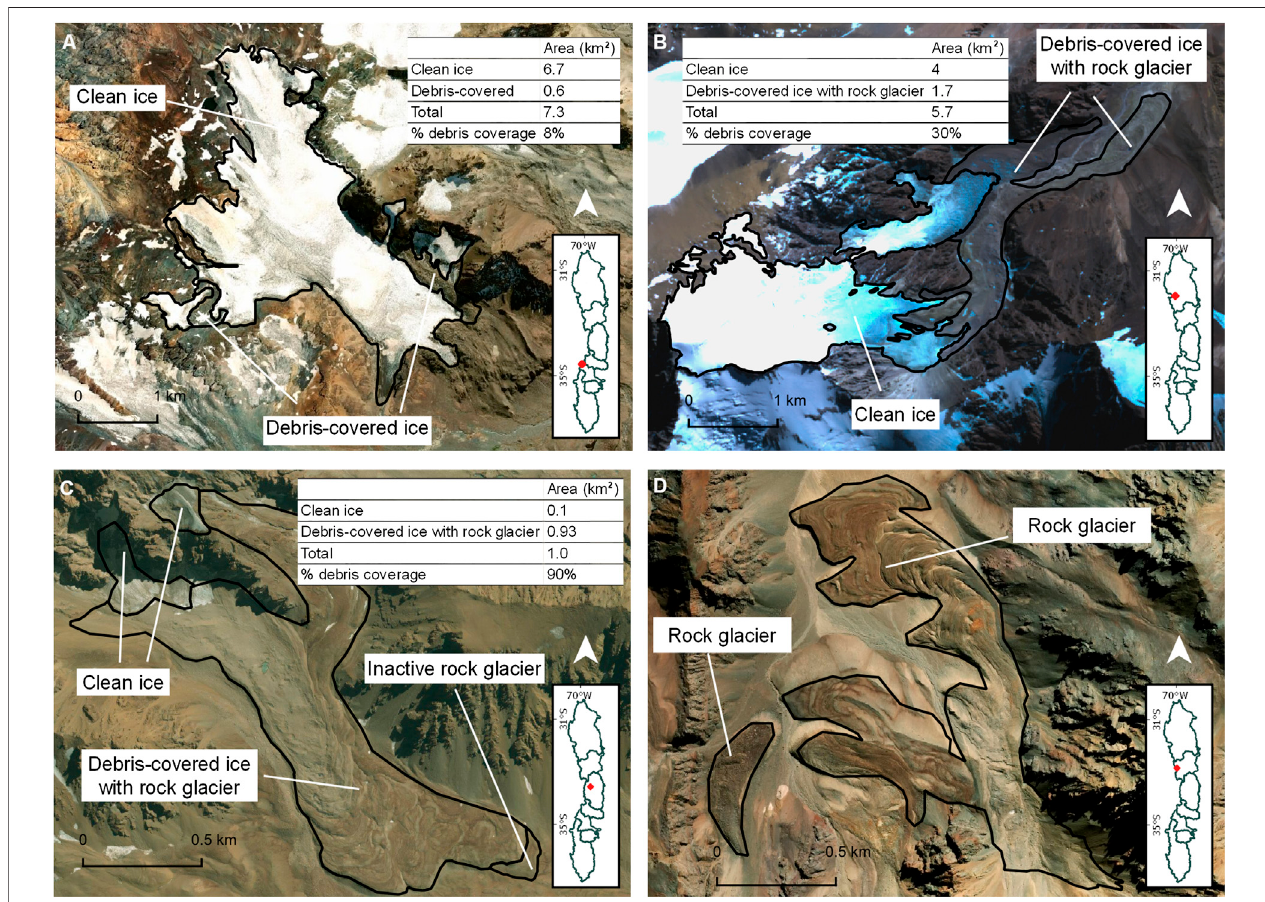
FIGURE 2 | Examples of ice masses showing the wide range of debris coverage that can be found in the study area. (A) Partly debris-covered glacier (8%) in the Atuelbasin. (B) Partlydebris-coveredicewithrockglacier(30%debriscoverage)intheSanJuanbasin. (C) Completelydebris-coveredicewithrockglacier(90%debris) in the Tunuyán basin. (D) Rock glacier (considered 100% covered by debris) in the Mendoza basin.fx.